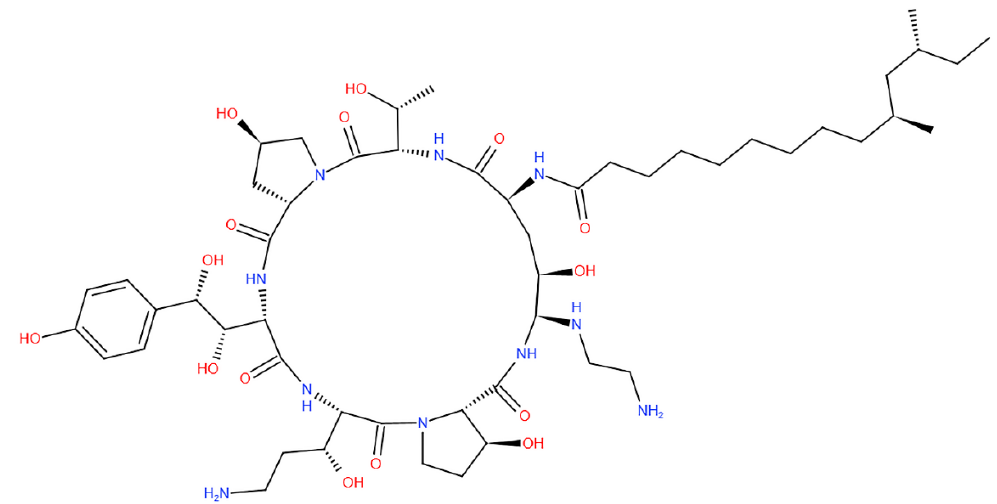
Figure 5. Chemical structure representing Caspofungin.